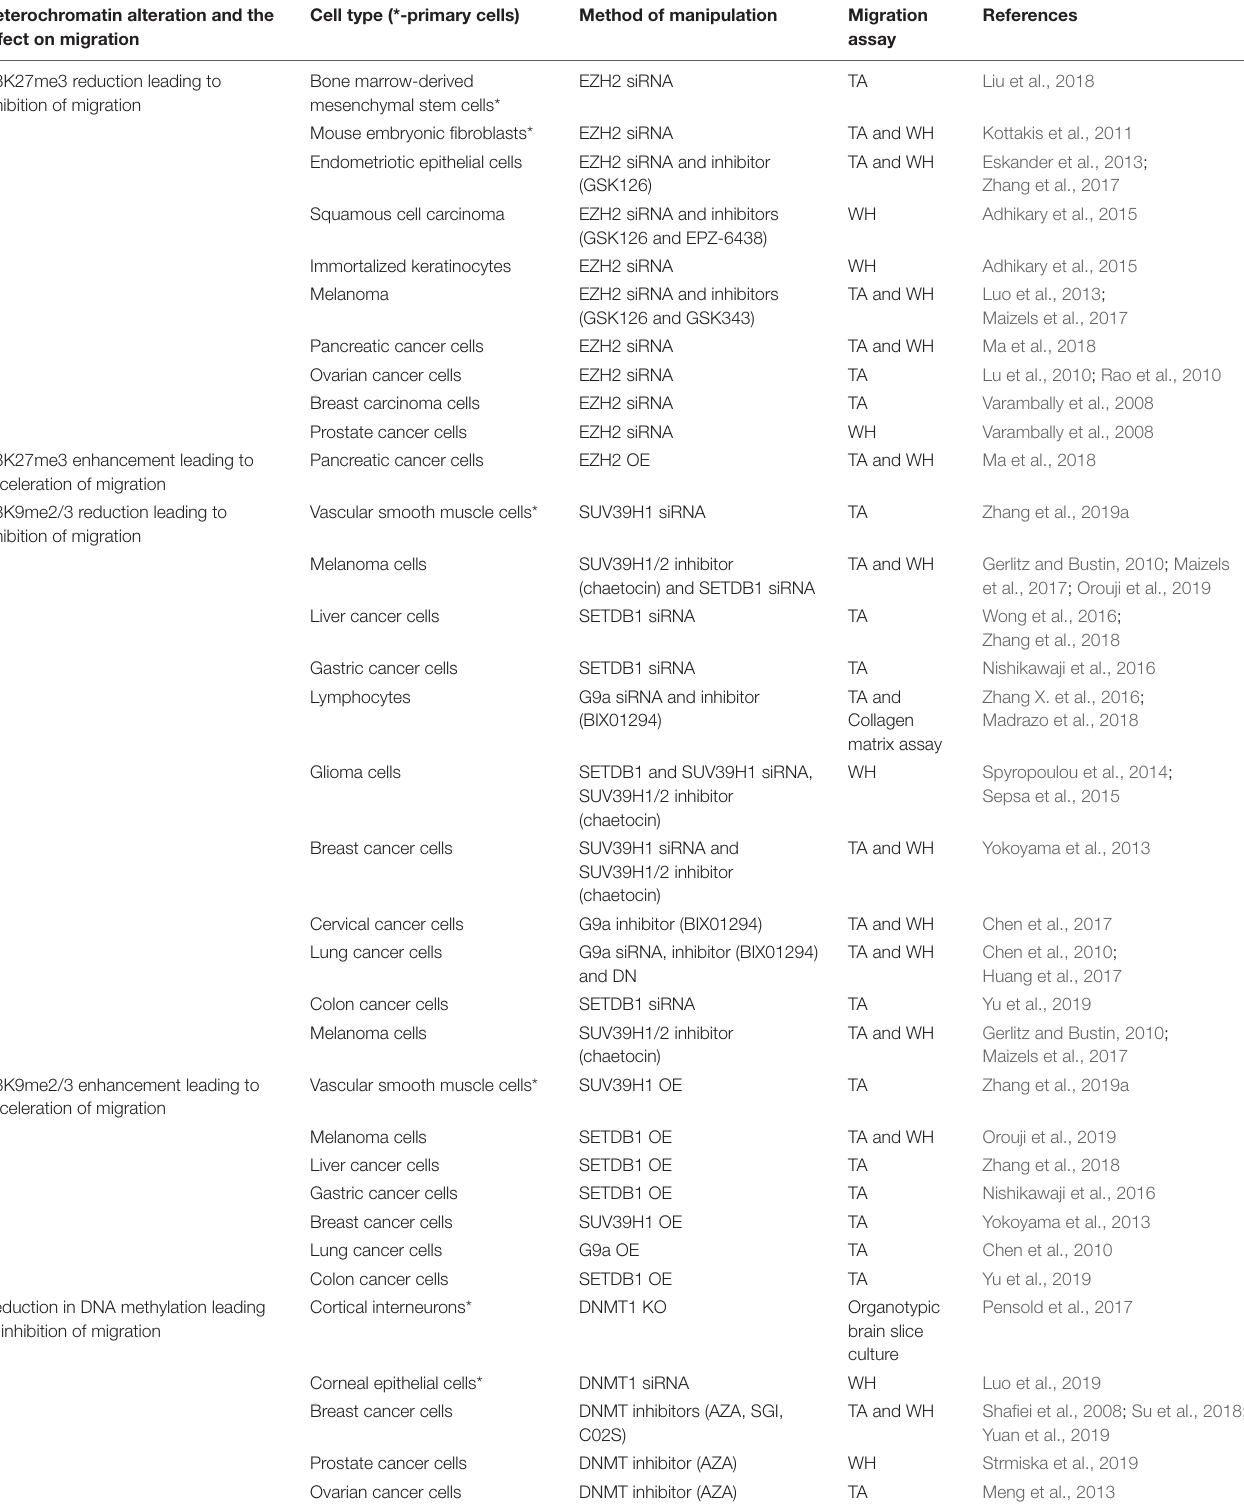
TABLE 1 | Studies identifying the dependence of cell migration on heterochromatin